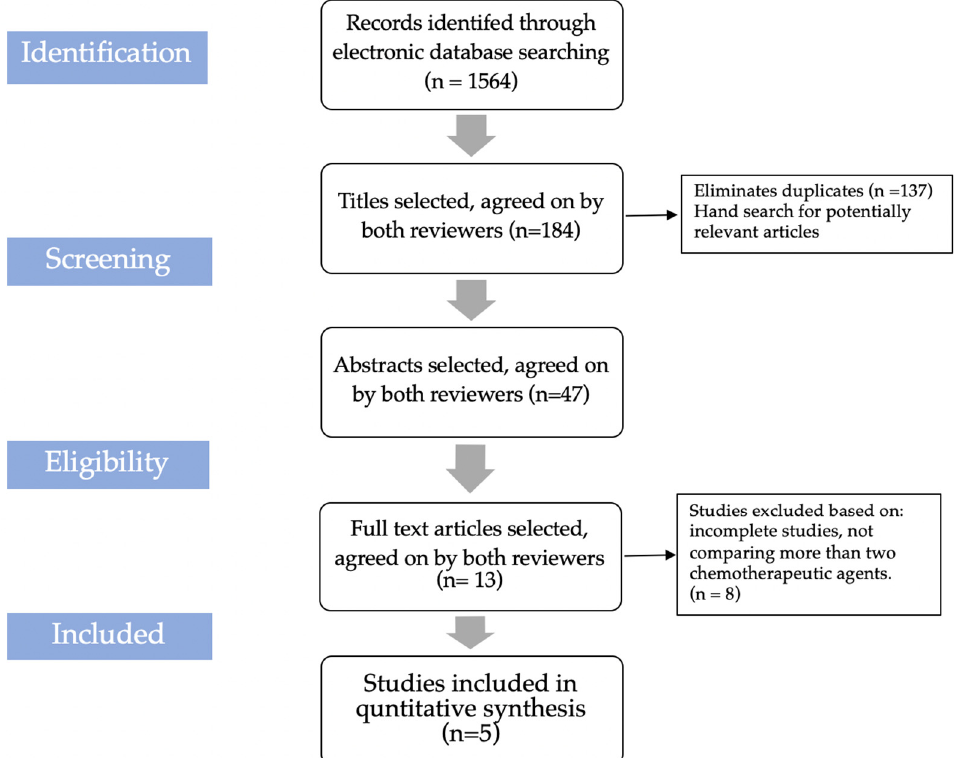
Figure 1. Literature search flowchart.